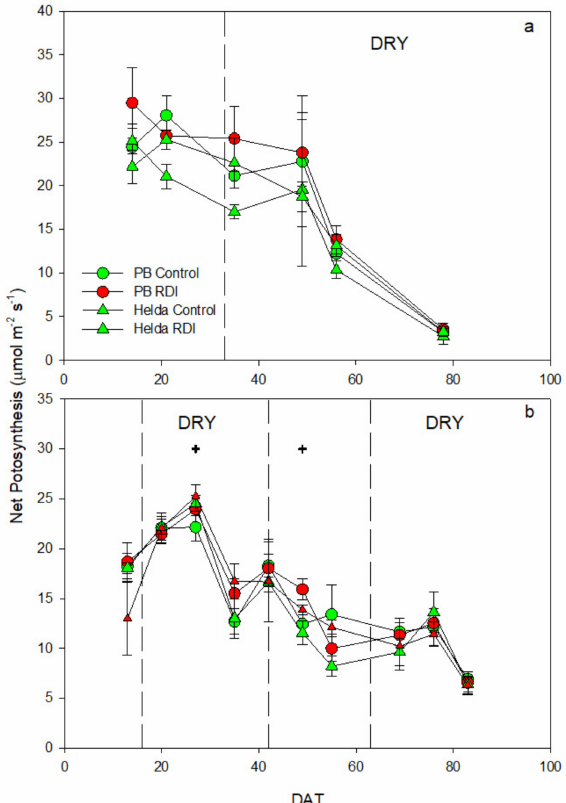
Figure 5. Pattern of midday leaf photosynthesis during the 2020 ( a ) and 2021 ( b ) seasons. Each point is the average of four measurements. Vertical lines represent the standard error. Triangles, cv Helda (upside down, Control; upright, RDI); Circles, cv Perfeccion Blanca (red, Control; orange, RDI). Crosses indicate significant differences between cultivars on that date. The word “dry” indicates a period of no